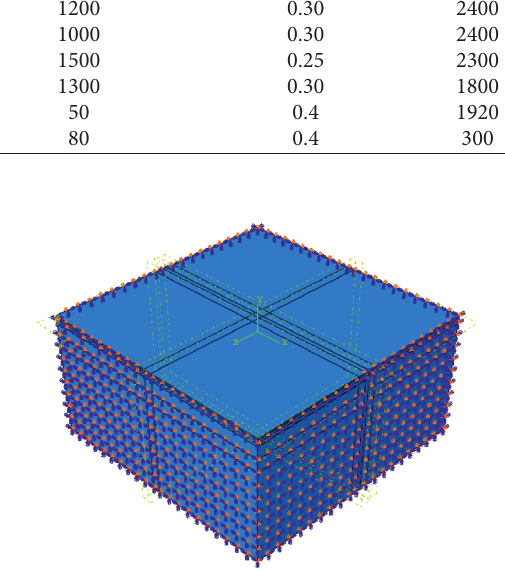
Figure 5: Boundary condition setting diagram of pavement structure model.